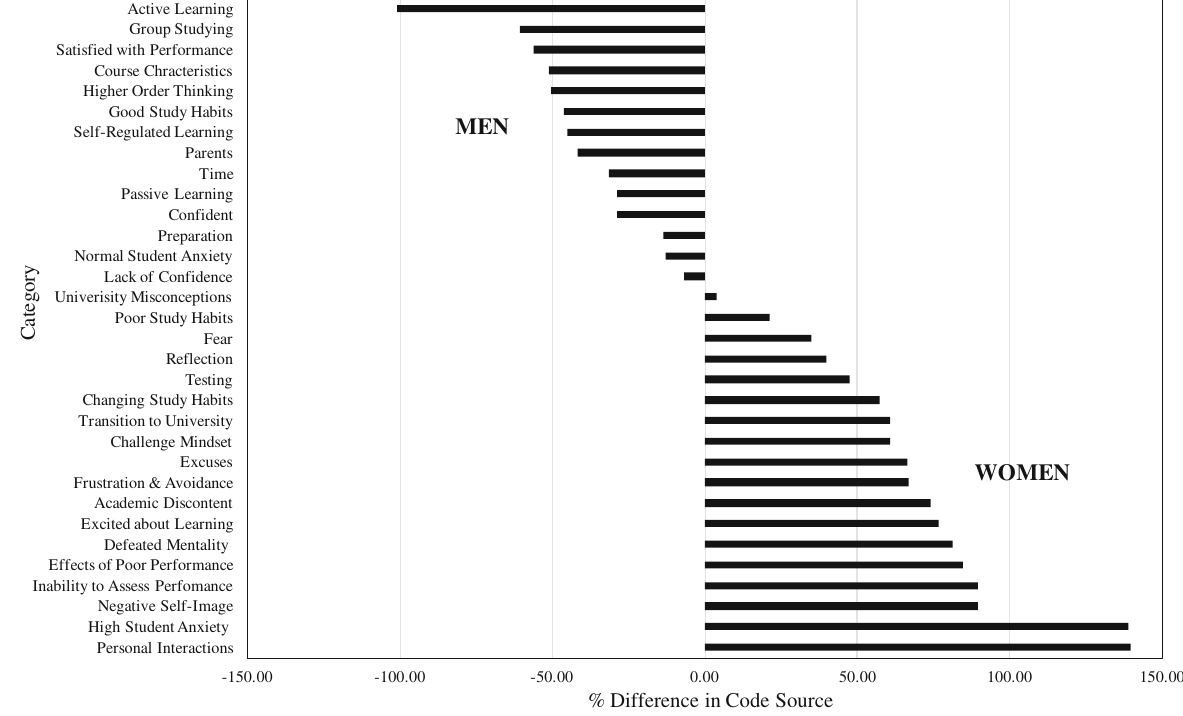
Fig. 2 Graph showing the percent difference between the number of quotations from male and female participants for each emergent category. Percent differences were calculated relative to the number of quotations from female